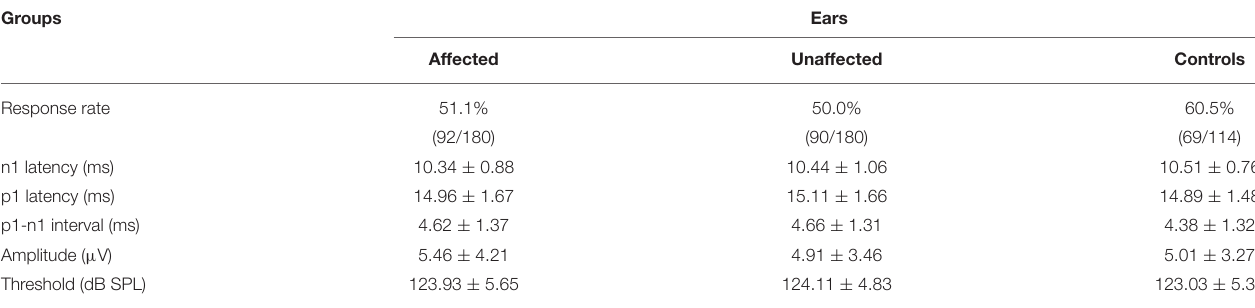
TABLE 5 | Comparison of ocular vestibular-evoked myogenic potential (oVEMP) parameters among affected, unaffected, and control ears.